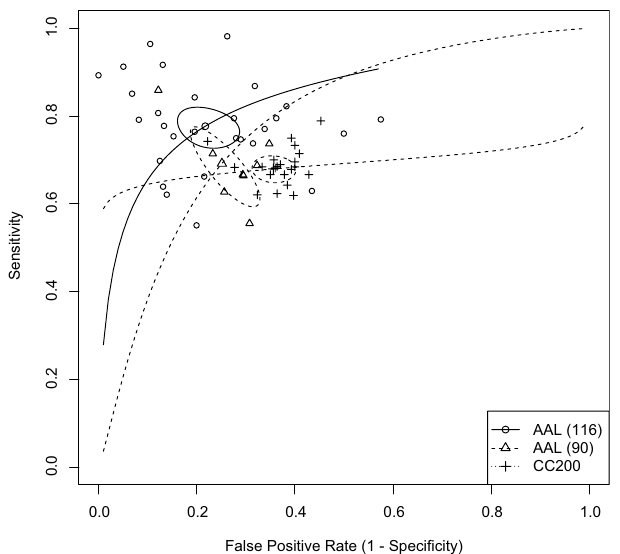
Figure 7. SROC curves of the studies using AAL90, AAL116, or CC200 with their summary estimates and confidence regions. Created with R Statistics 125 version 4.1.1 using the package mada 126 version